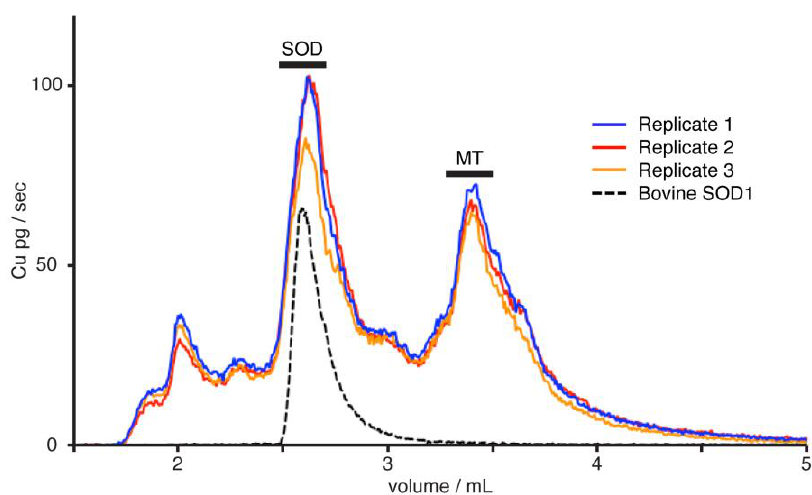
Figure 1. Size exclusion ICP-MS of copper proteins in human brain homogenate. The peak corresponding to the elution of Cu and Zn superoxide dismutase (SOD) and metallothionein (MT) are labelled. Bovine SOD was used as a standard (dashed line). The area of the SOD and the MT Cu peak comprise ca. 80% of the total soluble copper in human frontal cortex. Approximately 15% of the total Cu in the soluble fraction eluted between 1.5–2.4 mL.